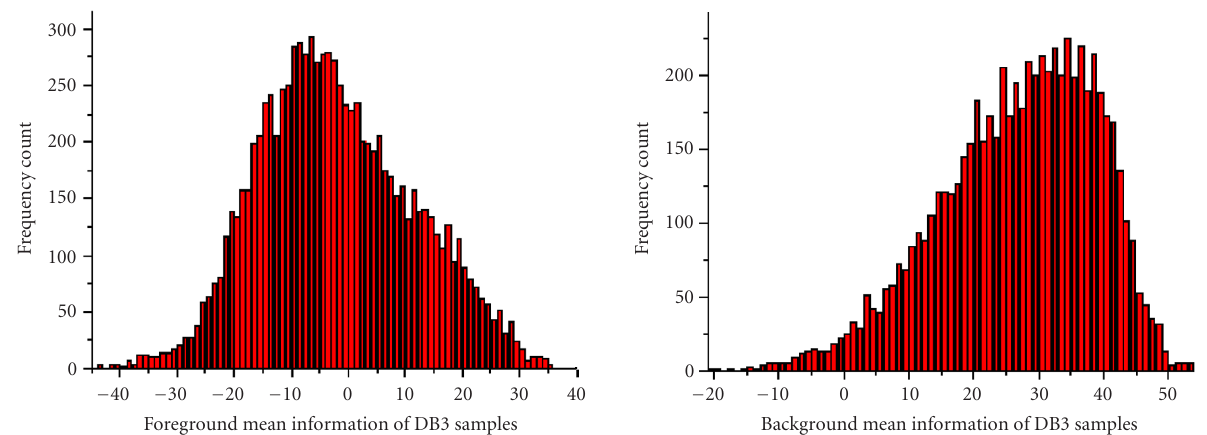
Figure 10: The block mean information MeanI of the samples. The horizontal coordinate represents the value of the block mean information while the vertical coordinate represents the frequency count of the value.